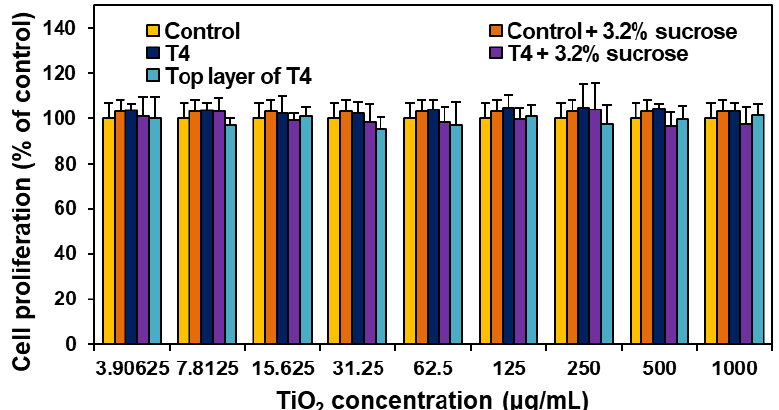
Figure 7. The effect of the smallest particle fraction of TiO 2 (T4), the top layer after size fractionation, on cell proliferation of Caco-2 cells after 24 h. No significant differences among controls (cells without particles), T4, and top layer of T4 were found ( p > 0.05). Nanomaterials 2019 , 9 , x FOR PEER REVIEW